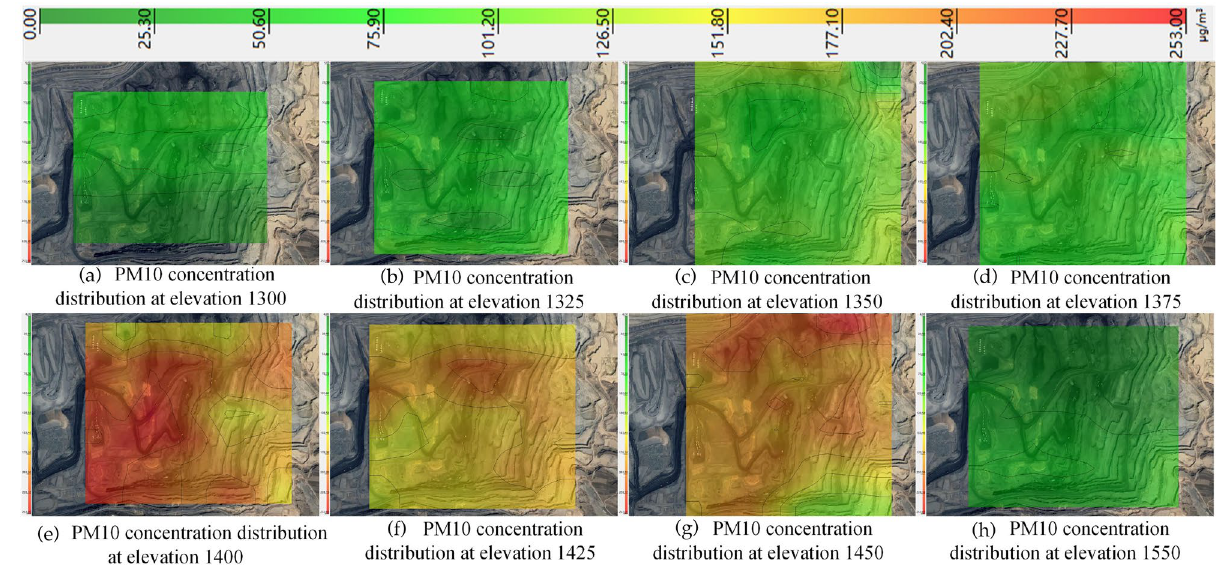
Figure 11. PM10 distribution from 1300 to 1550 elevation in winter.